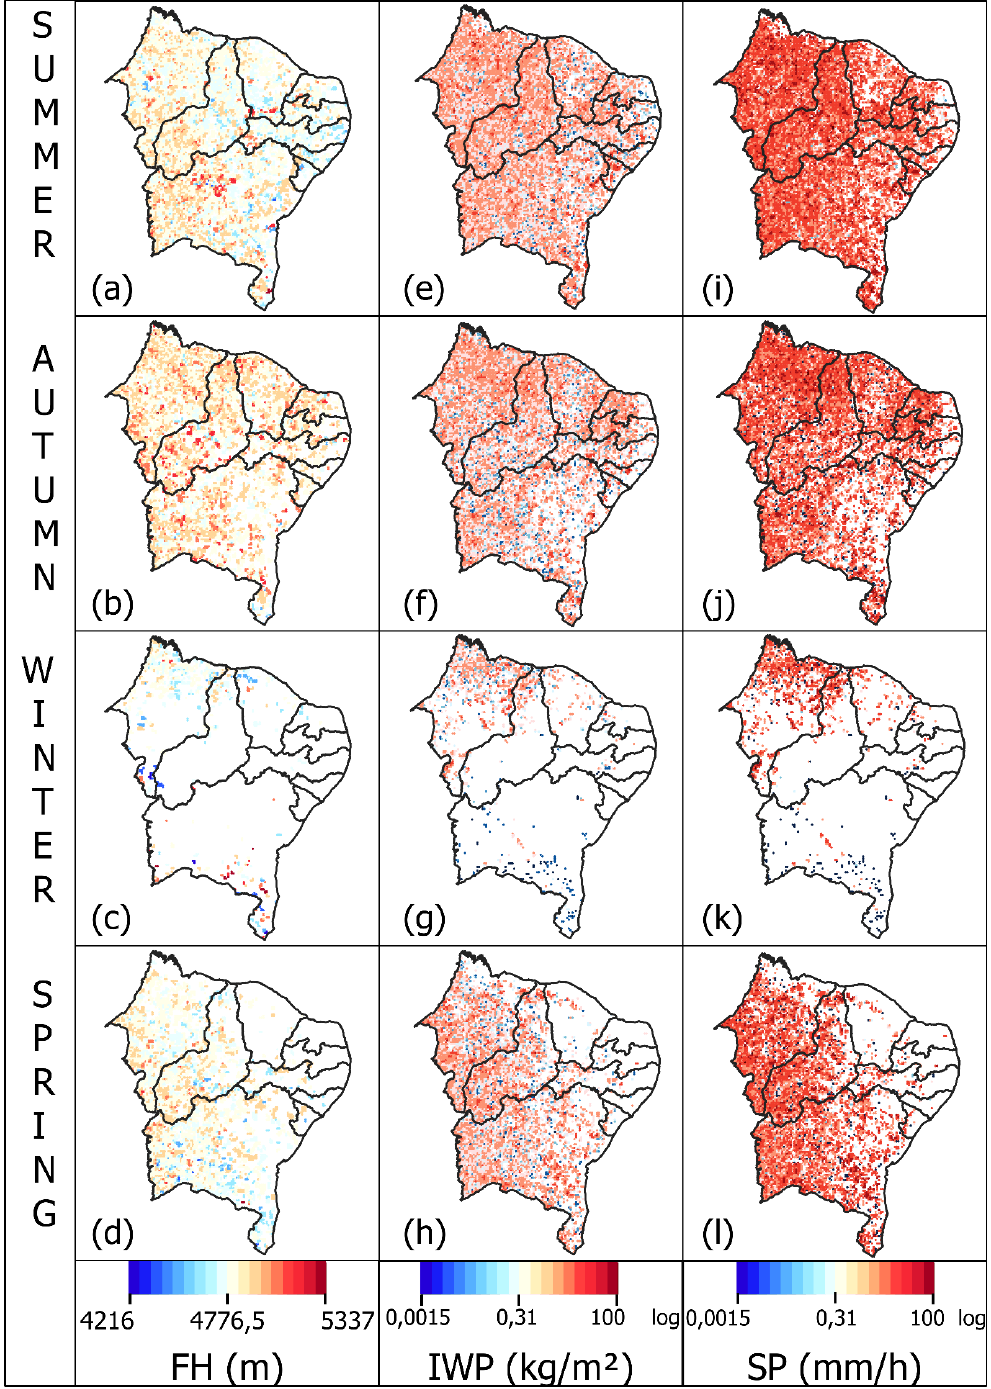
Figure 3. Spatial and seasonal distribution of ( a – d ) Freezing Level Height, ( e – h ) Ice Water Path, ( i – l ) Surface Precipitation; with 0.04 degrees spatial resolution.